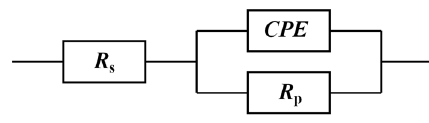
Figure 7: Equivalent circuit scheme ( R s – solution resistance, CPE – constant phase element, R p – polarization resistance ) .